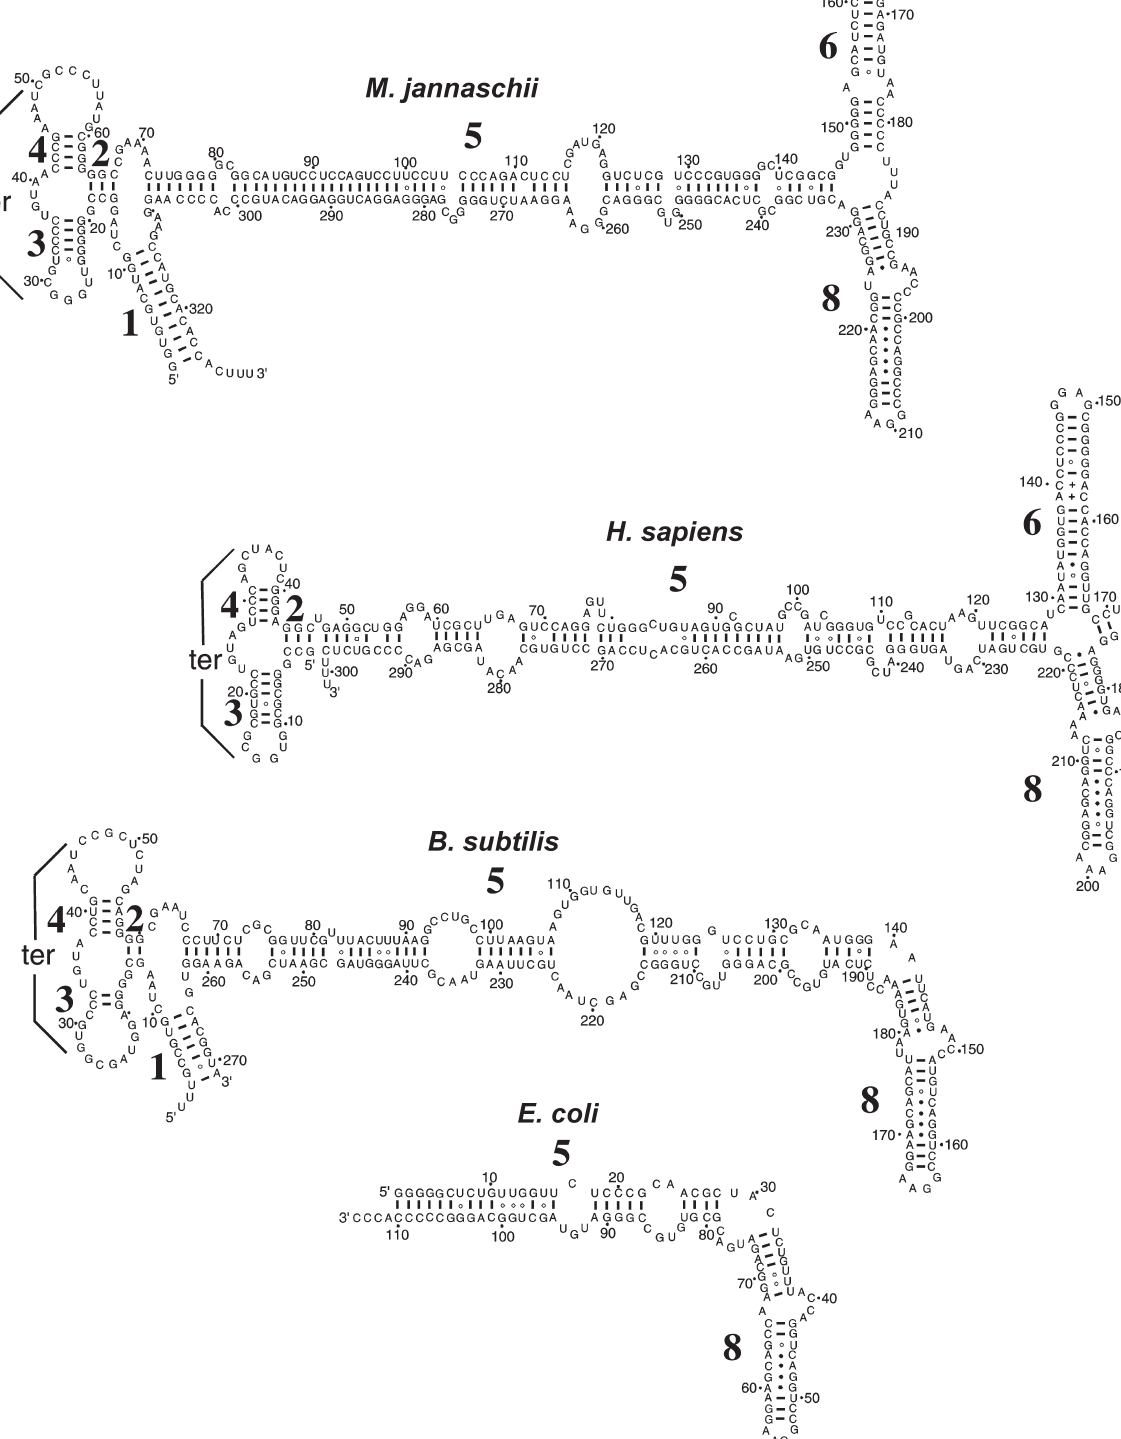
Figure 2. Secondary structures of signal recognition particle (SRP) RNA from Methanococcus jannaschii , Homo sapiens , Bacillus subtilis and Escherichia coli , with base pairings supported by comparative sequence analysis (Fox and Woese 1975). The 5 ′ and 3 ′ ends of RNA molecules are labeled, and helices are numbered 1 to 8 according to the nomenclature of Larsen and Zwieb (1991). One A–C and two A–G pairings in Helix 8 that exist in a homologous structure (Batey et al. 2000) are connected by dots. The “+” symbols in Helix 6 of human SRP RNA indicate interac- tions in the crystal structure of a 28-mer duplex (Wild et al. 1999). Residues are numbered in increments of 50 and marked in increments of 10 nu- cleotides. Tertiary interactions (“ter”) between the loops of Helices 3 and 4 are